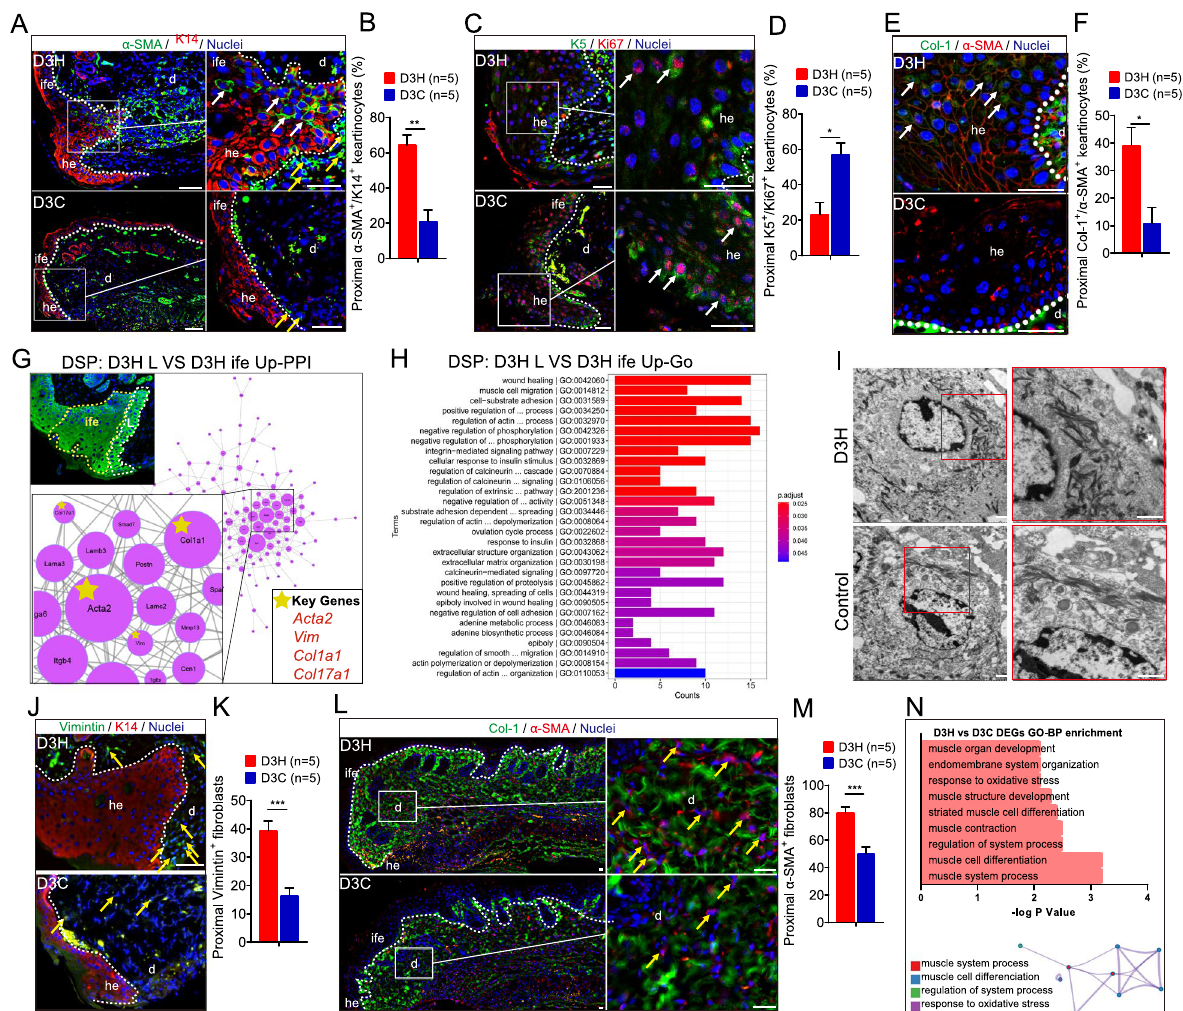
Fig. 3 H 2 induces myofibroblasts and fibroblasts migration and IFE towards α-SMA + myoepithelial cell transformation in the proximal wound. A , C , E , J Detection of α-SMA/K14, K5/ki67, Col-1/α-SMA and Vimintin/K14 in the leading edge of the proximal wound at day 3 post-wounding. L Col-1/ α-SMA co-expression in the dermal fibroblast of proximal wound at day 3 post-wounding. B , D , F , K and M quantification of double/single positive cells in A , C , E , J and M . G , H DSP transcriptome analysis of D3H proximal wound area (D3H leading edge vs D3H ife) showing the upregulated PPI network, key genes and up-GO biological processes in the keratinocytes of leading edge. White and yellow dotted circles indicate ROI of leading edge and ife, respectively. I Observation of keratinocyte tonofilament morphology in 66% H 2 and control groups by electron microscope. N GO-BP enrichment and enriched GO-BP clusters of D3H vs D3C DEGs by using metascape online analysis. White dotted line indicates the boundary between the epithelium and dermis. White arrows in A , C, and E indicate co-positive IFE cells, yellow arrows indicate Vimintin + ( J ) fibroblasts or Col-1 + /α-SMA + co-positive myofibroblasts ( L ). Data in B, D, F, K , and M processed Unpaired T test, and were plotted as Mean < 0.05; ** P value < 0.01; *** P value < 0.001; no stars for P value > 0.05; Scale bar in A , C , E , J , and L hypertrophic epidermal wound edge; ife, interfollicular epithelium. DSP, digital spatial